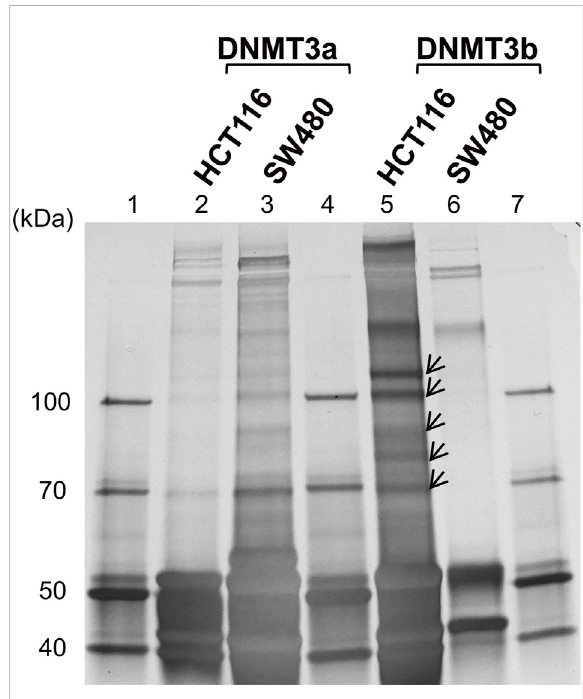
FIGURE 2 Identi fi cationof DNMT-interactingnuclear factors speci fi cto the IEC line with hypermethylated TLR4 gene. Pull-down assays of the nuclear extracts from HCT116 and SW480 cells were performed using antibodies against DNMT3a and DMNT3b. The precipitates were analyzed by silver staining. Lanes 1, 4, and 7, molecular-weight size marker; lane 2, HCT116 nuclear extract immunoprecipitated with anti-DNMT3a antibody; lane 3, SW480 nuclear extract immunoprecipitated with anti-DNMT3a antibody; lanes 5, HCT116 nuclear extract immunoprecipitated with anti-DNMT3b antibody; lane 6, SW480 nuclear extract immunoprecipitated with anti-DNMT3b antibody. Arrows indicate bandsspeci fi ctothenuclearextractofHCT116cellsandarenotor minimally observed in that of SW480 cells. Representative image of three independent experiments is